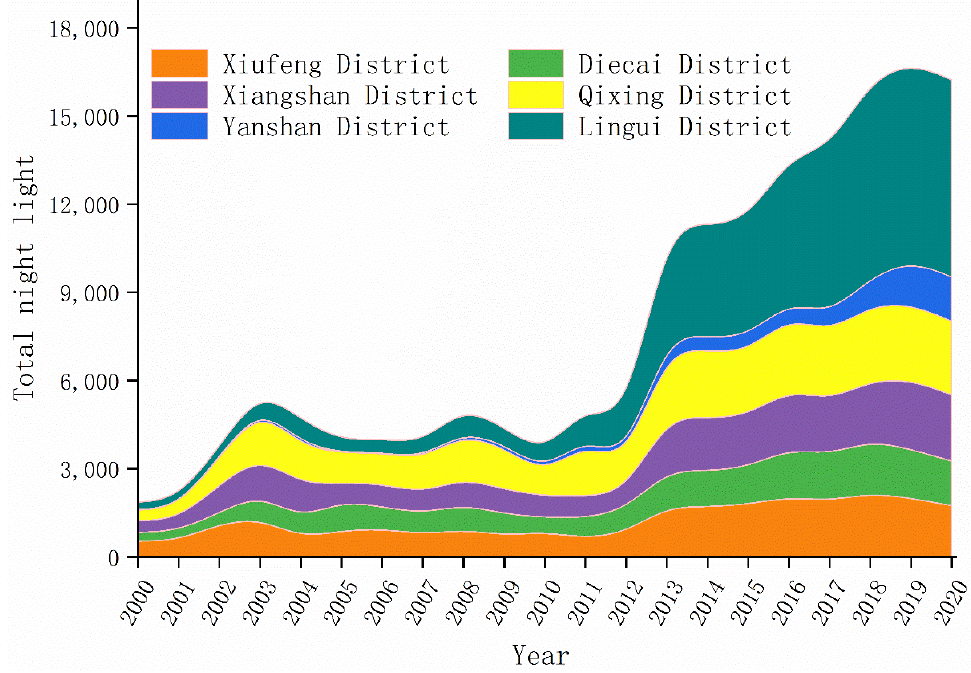
Figure 4. Changes in night-time light intensity in the urban area of Guilin from 2000 to 2020.